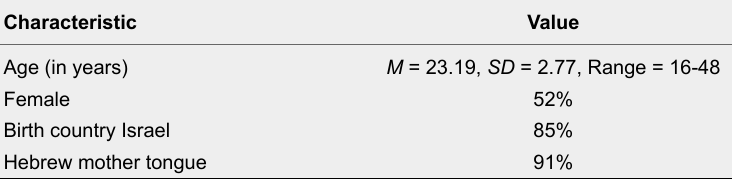
Demographics of the Dataset (N =